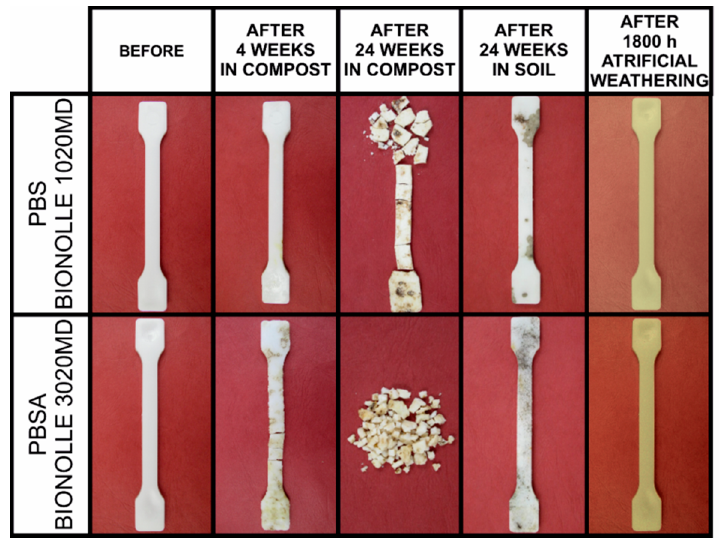
Figure 1. Photographs of the investigated samples before and after degradation.